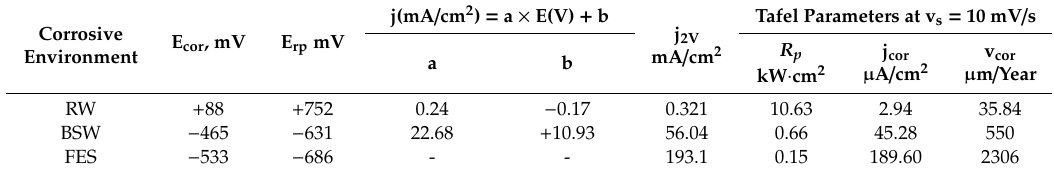
Figure 3. Cyclic voltammograms for the II-Zn sample. Table 9. Stimulated corrosion parameters for the II-Zn / Fe sample in the corrosive environments. Corrosive